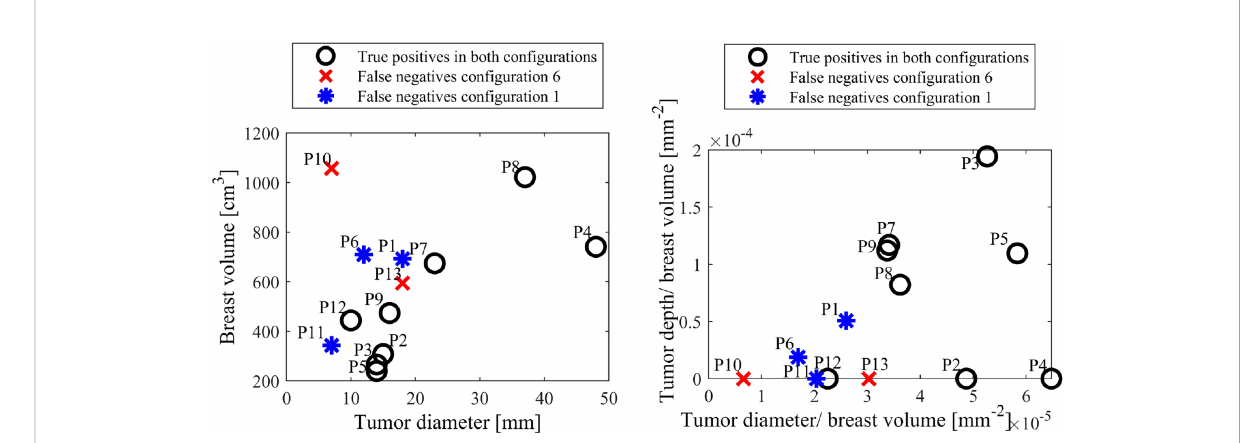
FIGURE 7 False negative tumor and breast sizes (left) and tumor depth and diameter normalised by breast volume (right) for con fi gurations 1 and